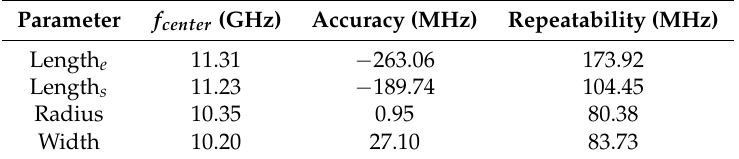
Table A2. Center Frequency, Accuracy and Repeatability Values for a Printed Spiral